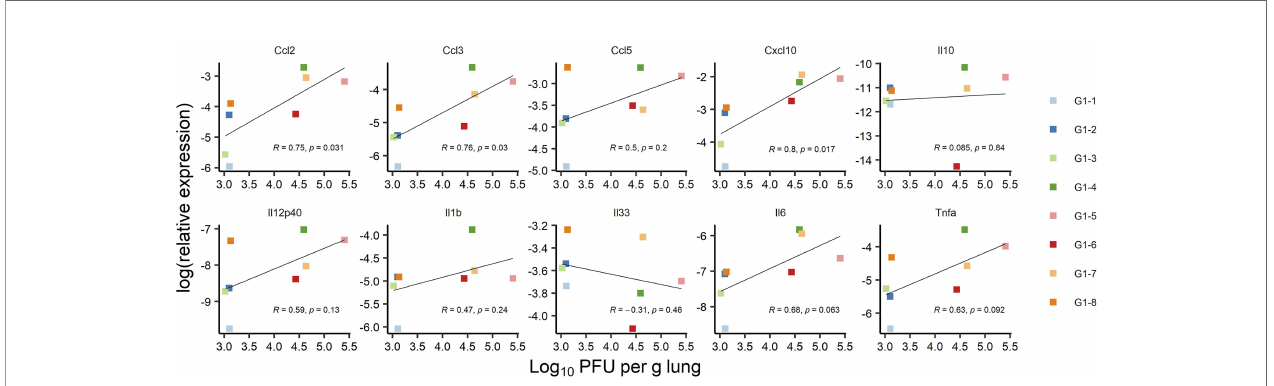
FIGURE 10 | Correlation between mRNA expression of ten cytokines and chemokines and lung infection at 3 dpi: Correlation between lung infection and cytokine or chemokine expression was assessed in infected K18-hACE2 transgenic mice of immunized Group 1 sacri fi ced at 3 dpi for lung collection (n= 8 with individual